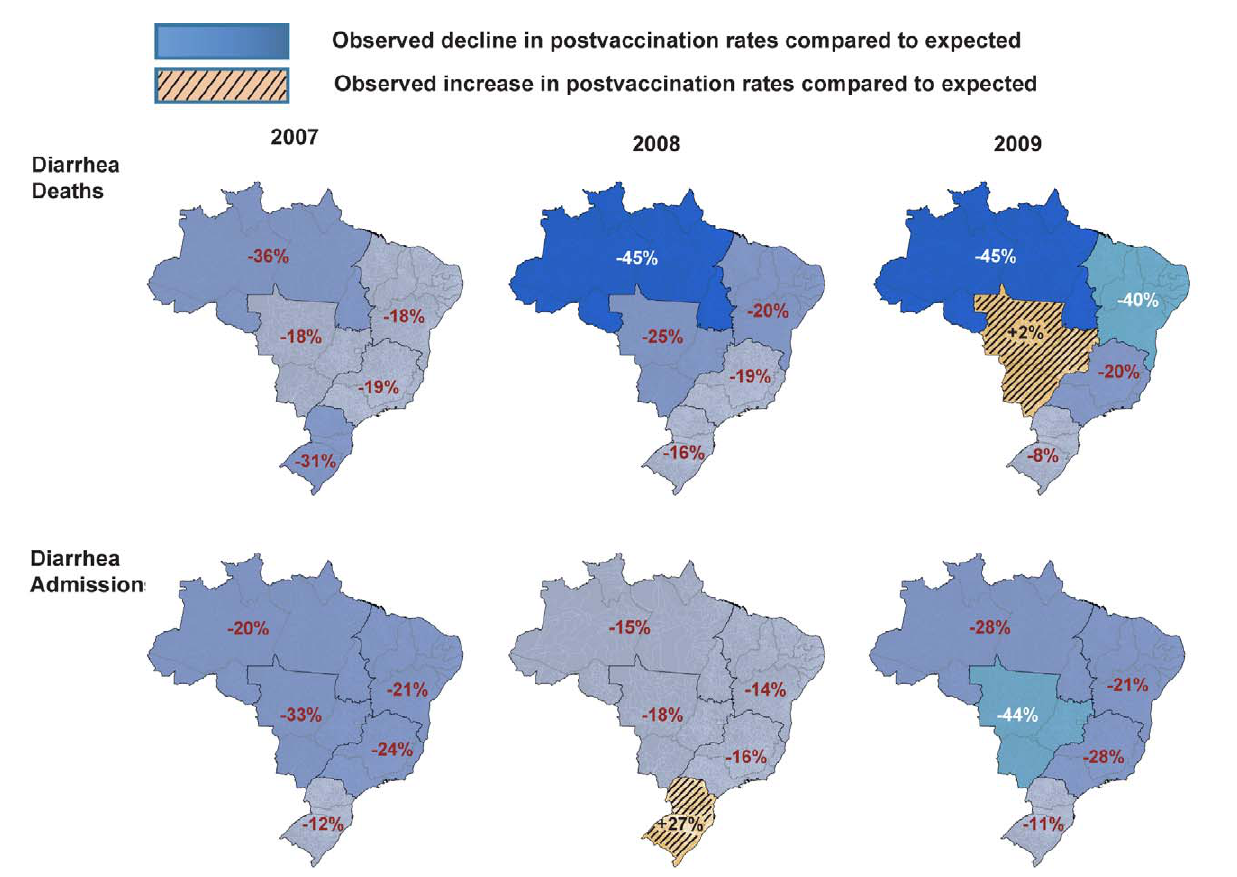
Figure 3. Change in diarrhea mortality and admission rates after vaccination by year and region. The maps depict the percent change in observed rates of diarrhea mortality and admission after rotavirus vaccination in Brazil compared to expected rates without a vaccination program, by year and region. Expected numbers of events are based on predictions from regression models fitted to historic data from each region (2002 to 2005). The percent declines are computed as one minus the RR of diarrhea events post-vaccine compared to the pre-vaccine era from Poisson regression models, adjusting for seasonality and secular trends.